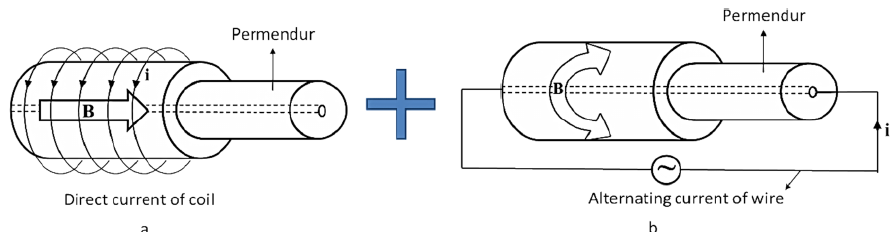
Figure 9. The working principle of a magnetostrictive torsional transducer [106]. The total magnetic field is given by the superposition of an axial component ( a ) and a circular component ( b ) (Reprinted with permission from